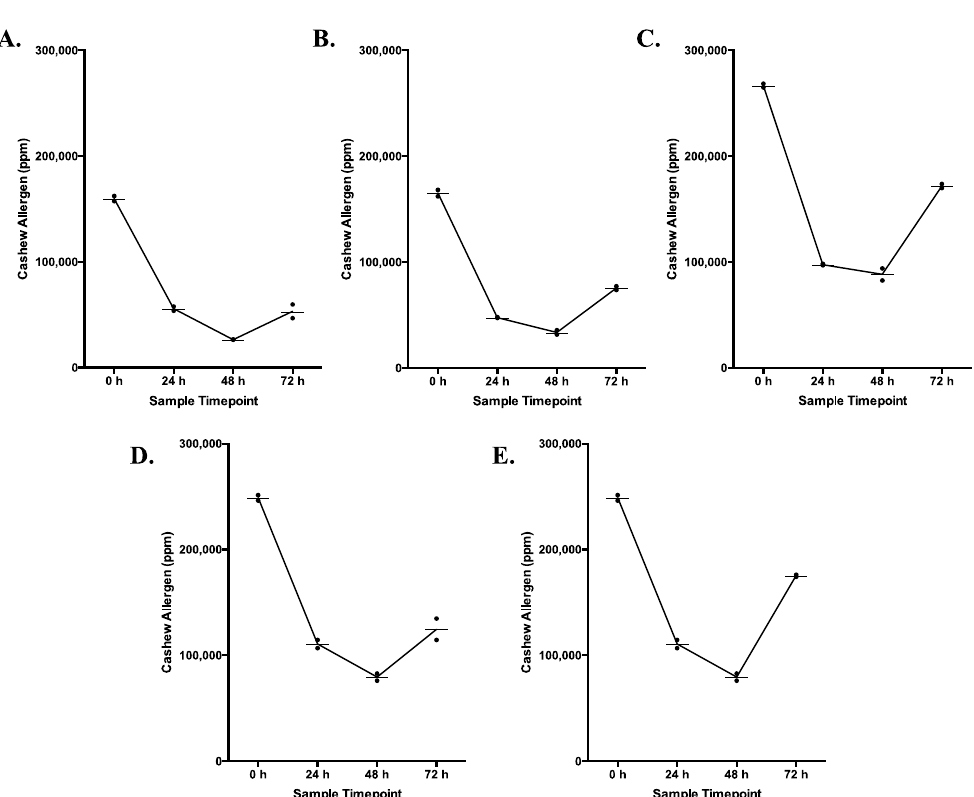
Figure 5. Cashew allergen concentration (ppm) through four timepoints of five fermented cashew products: ( A ) ‘cheddar’, ( B ) ‘blue’, ( C ) ‘brie’, ( D ) herb, and ( E ) red. Each batch was followed from 0 h